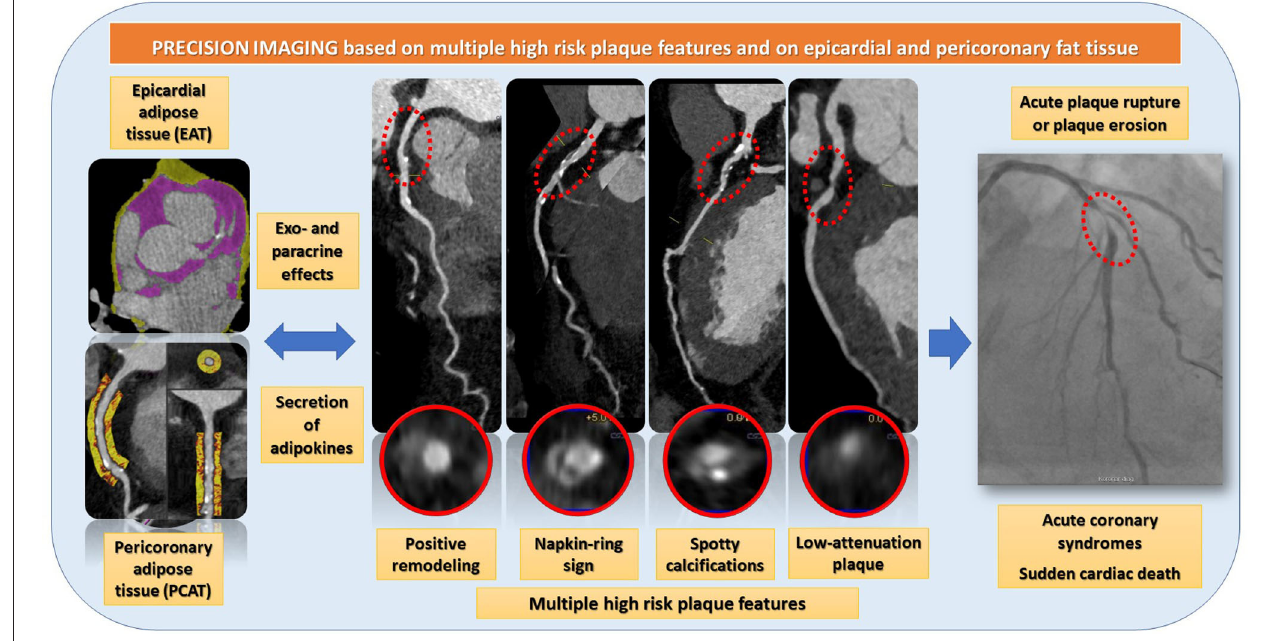
FIGURE 1 | CCTA can visualize and precisely quantify both EAT, PCAT and coronary plaque composition and burden within a single examination. EAT and PCAT are associated with high-risk plaque features, such as positive remodeling, the napkin ring sign, spotty calcifications, and low-attenuation plaques. Such high-risk plaques are rupture prone and therefor potential precursors of acute coronary